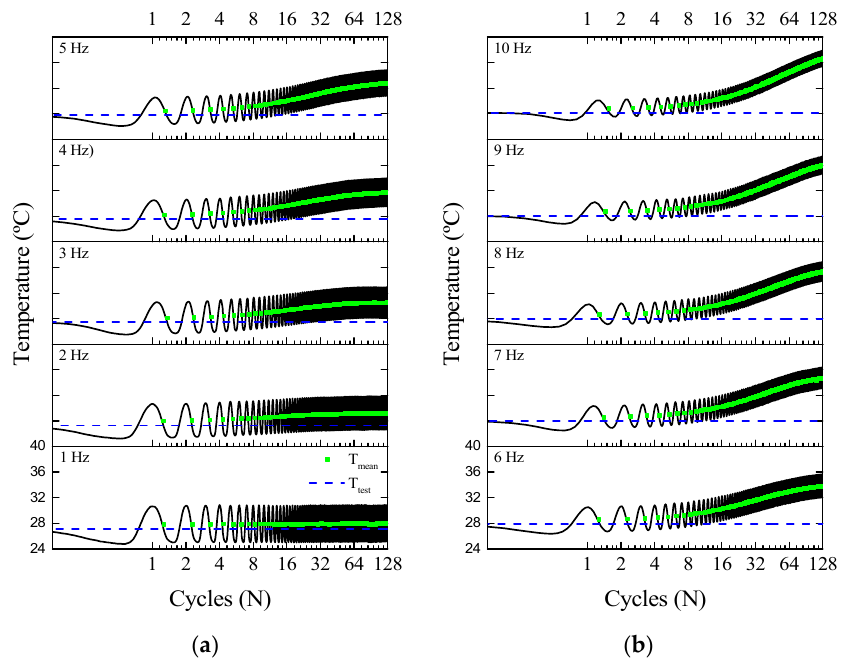
Figure 10. Temperature response over cycles. ( a ) from 1 Hz to 5 Hz. ( b ) from 6 Hz to 10 Hz.